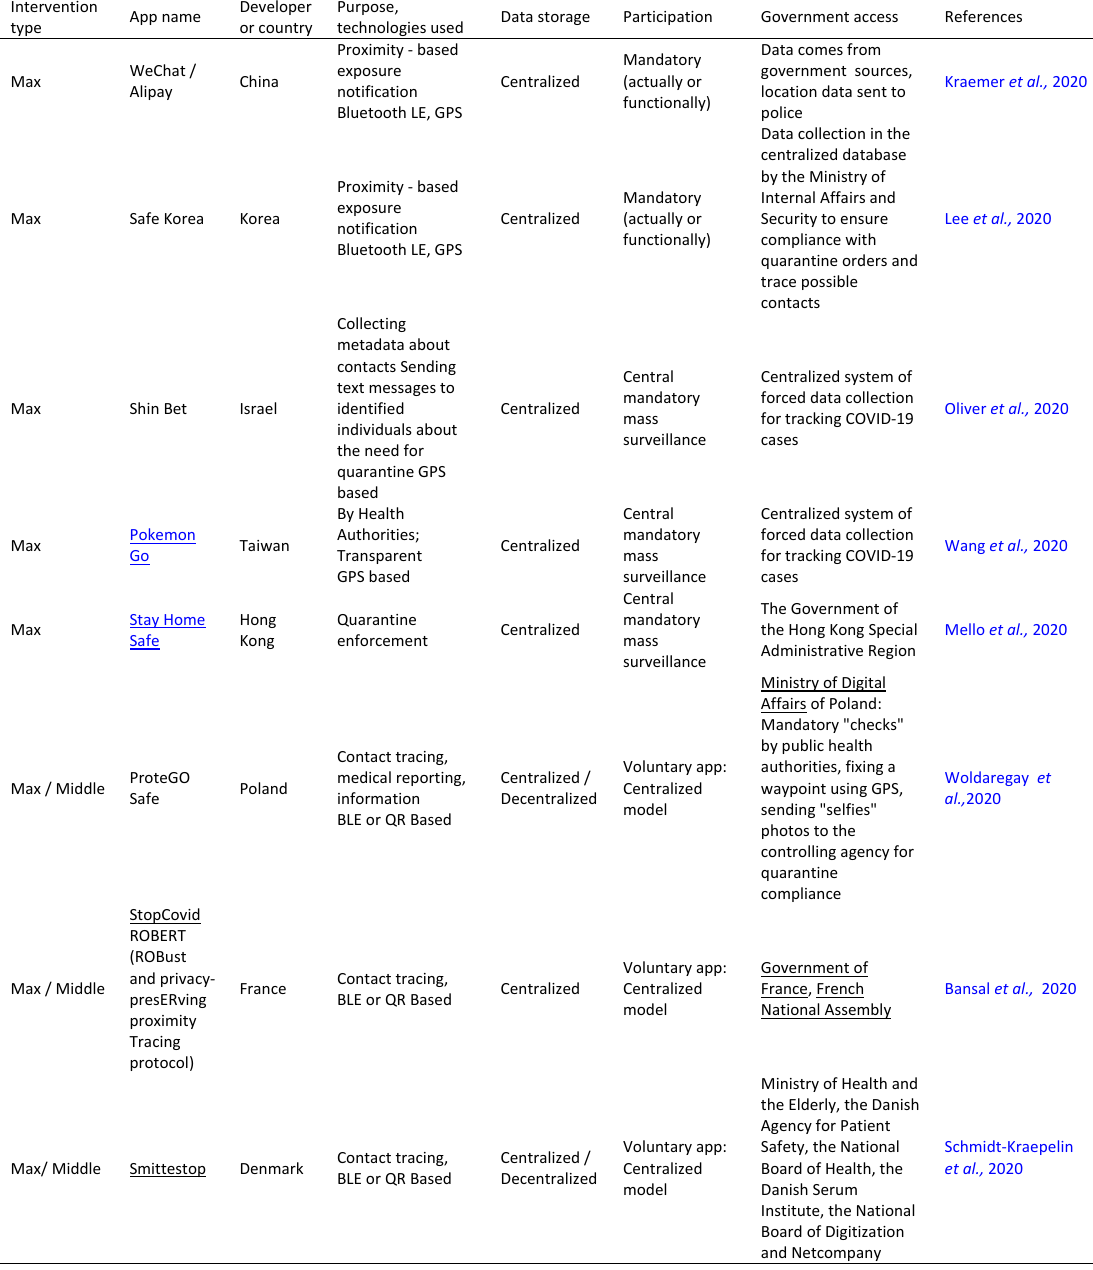
Table 1: The most common digital technologies and platforms tracking contacts for active surveillance over the spread of COVID-19